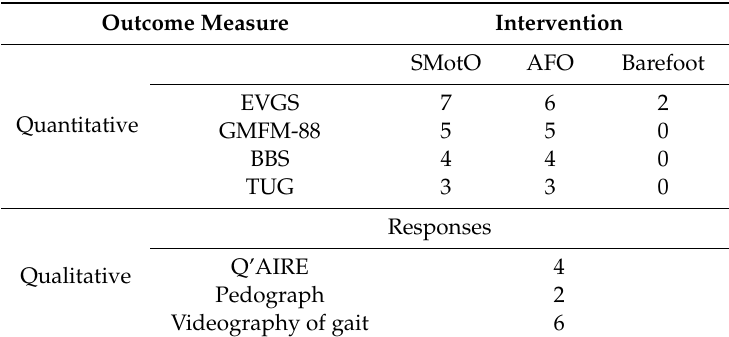
Table 1. Participant quantitative and qualitative outcome measure responses.